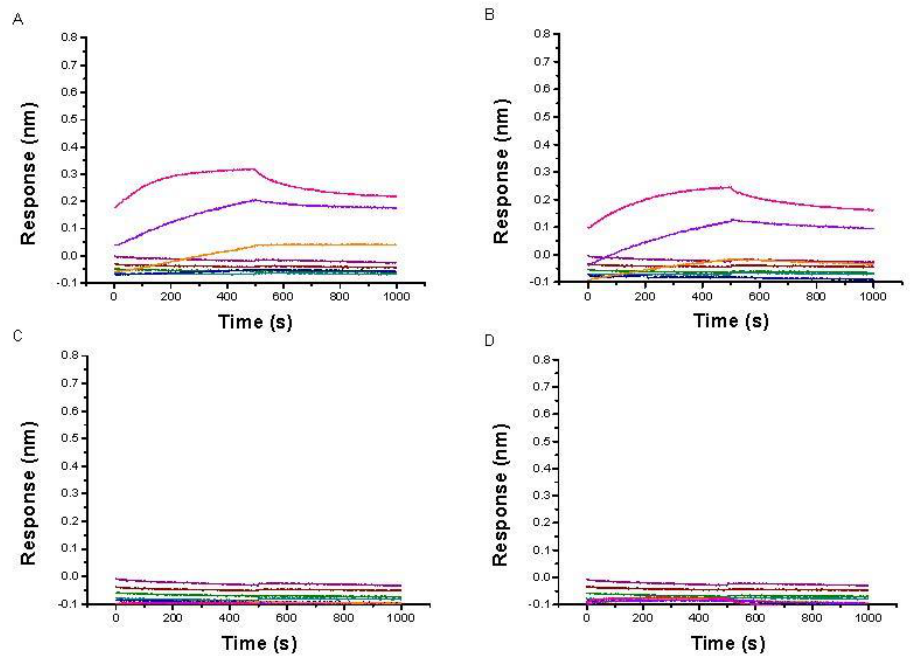
Figure 4. Sensorgrams recorded at pH 7.5 for the recognition of IMC-48 with immobilized sequences: ( A ) HRAS ; ( B ) bcl-2 ; ( C ) HTelo-C ; and ( D ) c-myc . Concentration range: 0.1 (blue), 0.5 (brown), 1 (green), 5 (dark cyan), 10 (black), 25 (orange), 50 (violet), and 100 µM (pink). Buffer composition: 50 mM TrisHCl, 50 mM KCl, 2% DMSO and 0.05% v/v surfactant P20.